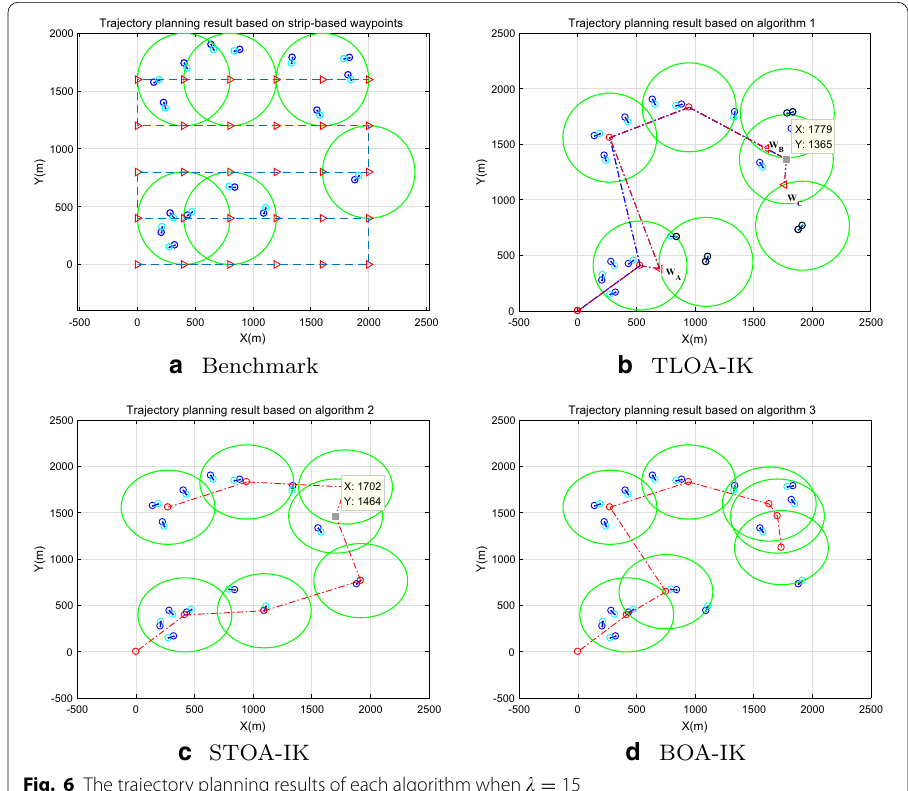
Fig. 6 The trajectory planning results of each algorithm when (cid:31) =